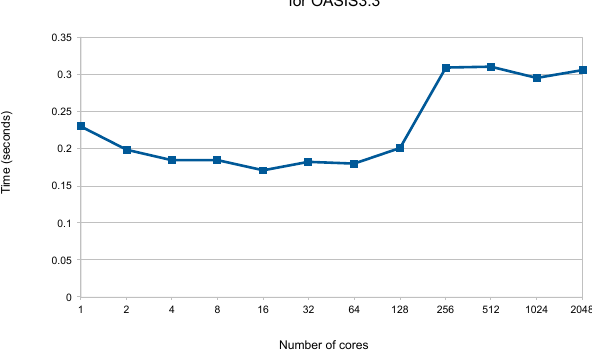
Fig. 3. Elapse time (in second) on Curie Bullx for one ping-pong exchange with OASIS3 between two toy components, one using a 0.25 degree logically rectangular grid (1021 × 1442 grid points) and the other using a Gaussian Reduced T799 grid (843000 grid points) for 1 to 2048 cores per